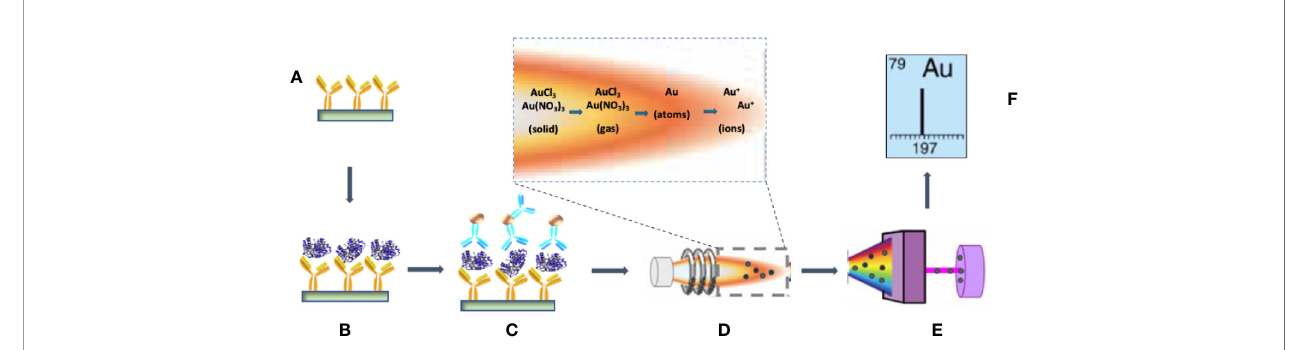
FIGURE 1 | Schematic of the processes involved in the immunoassay detection of PfLDH by ICP-MS. (A) The test tubes are coated with the primary anti-PfLDH monoclonal antibody (mAb). (B) After blocking with BSA and washing, PfLDH antigens are captured by the primary mAb. (C) AuNP-labeled detection mAbs are bound to the capture PfLDH molecules. (D) The AuNP – protein complexes are dissolved in the aqua regia for injection into the spray chamber. ICP, which is a plasma sustained by inductively coupled radio frequency energy via a load coil after generation from a stream of argon passed through a quartz torch, serves as the ionization source. In the vaporization and ionization phase, the droplets of the sample travel through the different heating zones, in which they are dried by the plasma torch, vaporized, atomized, and fi nally ionized. (E) Ions are separated by the mass analyzer. (F) The detector displays the isotopic fi ngerprint and the analyte ion count rate, which is proportional to the mass fraction of the analyte in the sample droplets.